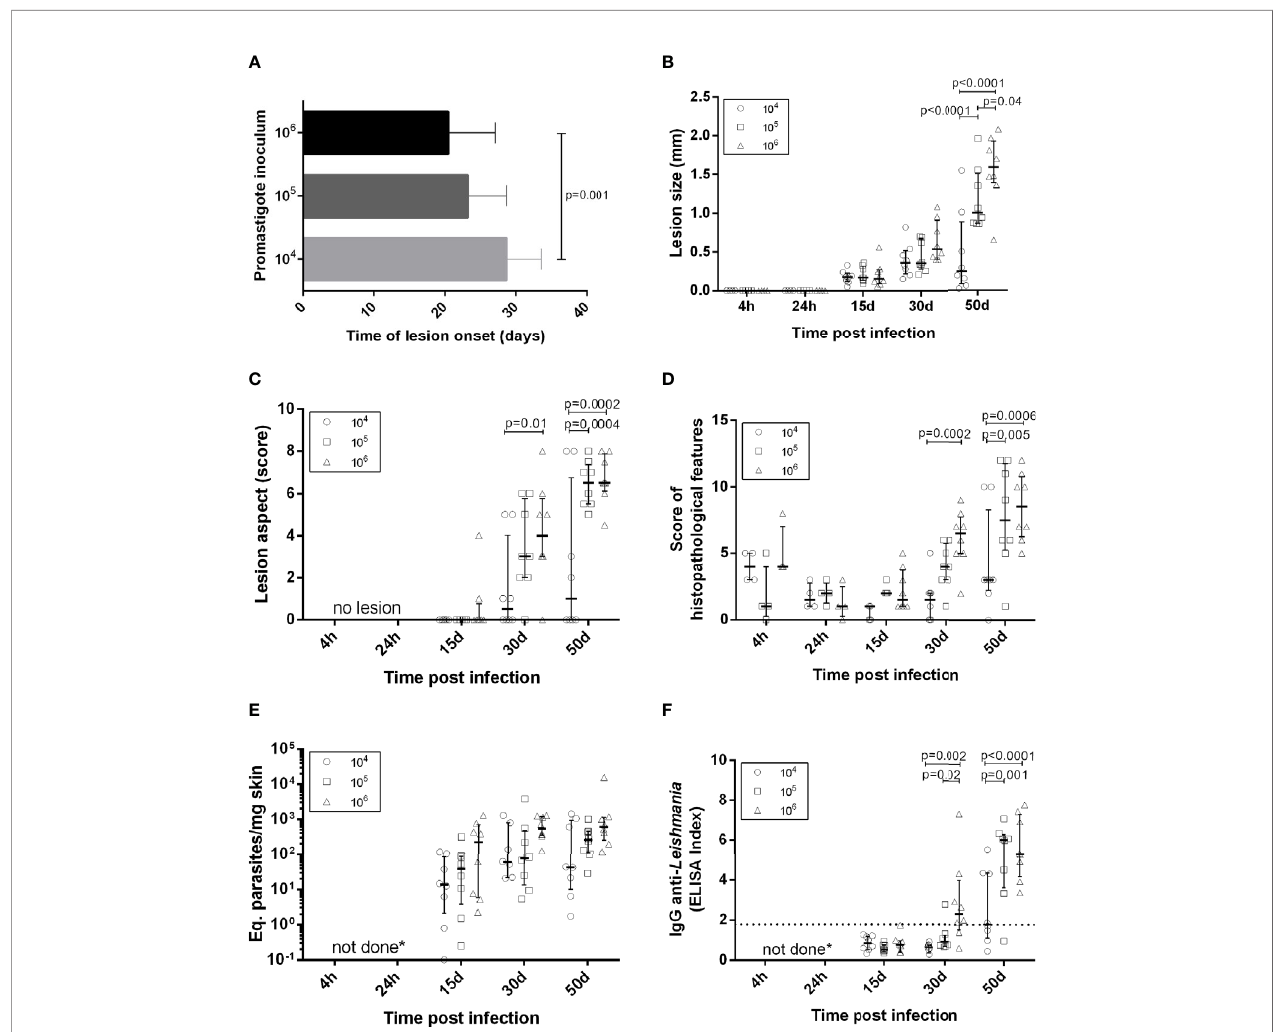
FIGURE 1 | Clinical, parasitological and immunological aspects in golden hamsters infected with Leishmania (Viannia) braziliensis . The animals were followed-up during the fi rst hours (4h, 24h), early (15 days and 30 days) and late (50 days) post-infection phases. (A) Time of lesion onset; (B) Lesion size was de fi ned by the difference in millimeters (mm) between the thickness of the infected and the non-infected paw of the same animal; (C) Lesions scores (s) were de fi ned as follows: no lesion (s=0), edema (s=1), discrete papule (s=2), moderate papule (s=3), discrete nodule (s=4), moderate nodule (s=5), large nodule (s=6), very large nodule (s=7), and, if ulcers were present, associated with early ulcer (s=0.5), ulcer (s=1), ulcer with crust (s=1.5), deep ulcer (s=2) (D) Regarding histopathological scores: no observation (score=0), slight (score=1), moderate (score=2) and intense (score=3); (E) Parasite loads were quanti fi ed in the lesions by qPCR and the results were expressed as Equivalent parasites per milligram of skin; (F) Anti-IgG levels were quanti fi ed in plasma by an ELISA and the results were expressed as an Elisa Index. 10 4 (o), 10 5 ( ), 10 6 ( D ) – number of promastigotes used for infection; Each symbol represents one animal; The lines in each scatter group represent the median and interquartile range; the dotted line indicates the cutoff value for IgG quantitation; p – Statistical signi fi